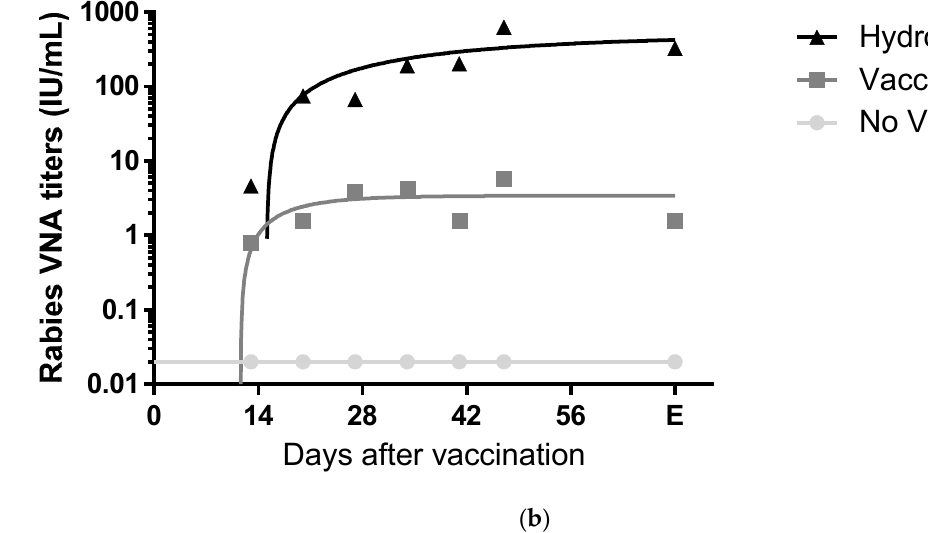
Figure 2. Dynamics of rabies virus-neutralizing antibody titers after immunization in mice. ( a ) Geometric mean titer with standard deviation and ( b ) non-linear curve fit for each group at each time point are shown on a log-scale. Mice in Group A ( n = 10) received no vaccine. Mice in Group B ( n = 20) received inactivated ERA-2GnRH (Vaccine only). Mice in Group C ( n = 20) received an equivalent dose of inactivated ERA-2GnRH in a chitosan hydrogel (Hydro). The end of the study (E) was approximately 70 days post-vaccination but varied for each group based on fertility.